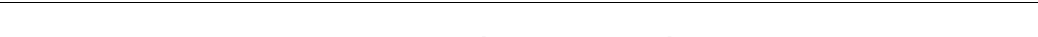
Figure 2. Horse, Nursery and Greenhouse, Tourism, and Recreation Sales by County Type,